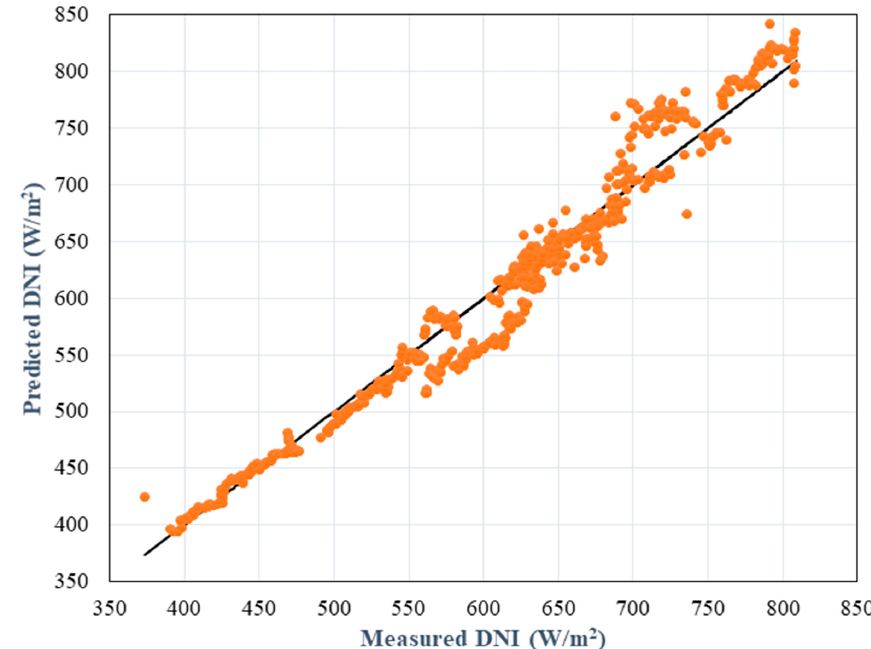
Figure 3. Validation results of the training process.